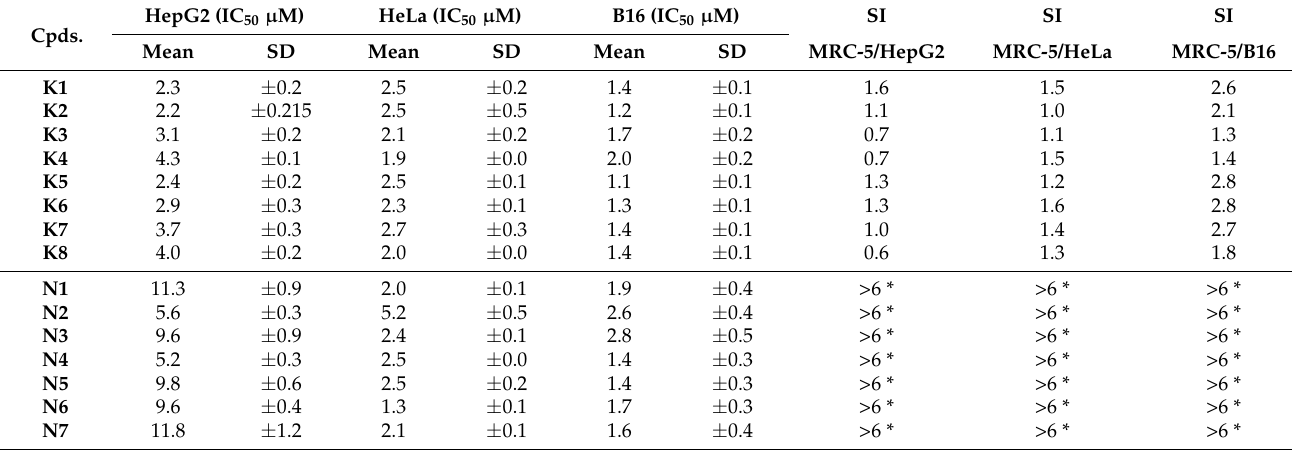
Table 4. Cytotoxic effect of selenocompounds on hepatocellular carcinoma (HepG2), cervical adenocarcinoma (HeLa), and skin melanoma (B16) cell lines and selectivity indexes (SI).